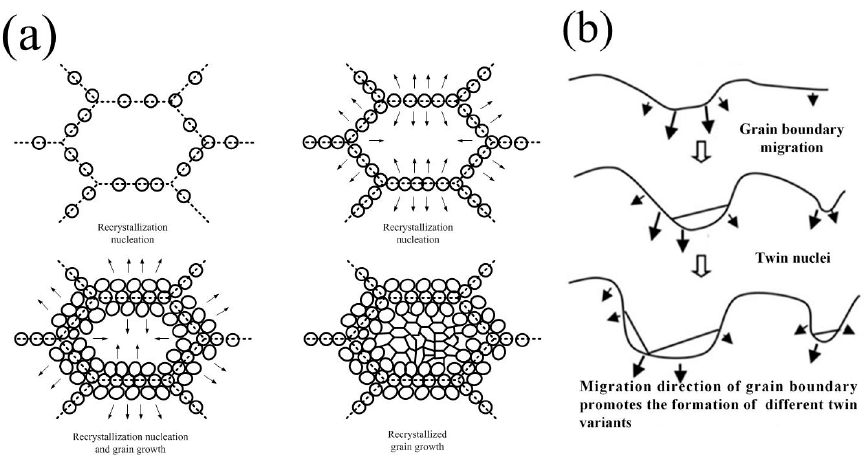
Figure 7. Schematic illustration of the recrystallization nucleation and grain growth ( a ) and the migration direction of grain boundary promotes the nucleation of different annealing twin variants during ASHR process ( b ).